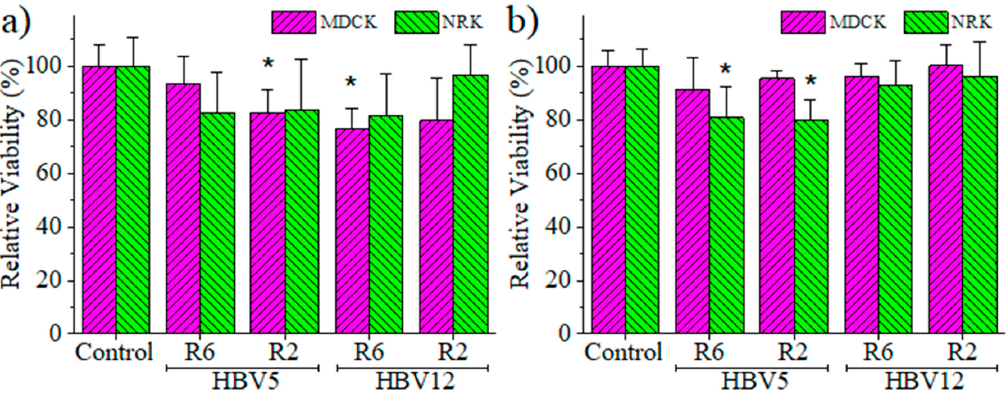
Figure 8. Cell viability of NRK and MDCK epithelial cells for adhesion ( a ) and proliferation ( b ) assays in the HBV5 and HBV12 scaffolds obtained from 1,4-dioxane solutions cooled at rates of 2 and 6 °C/min. * p < 0.05 vs. control.